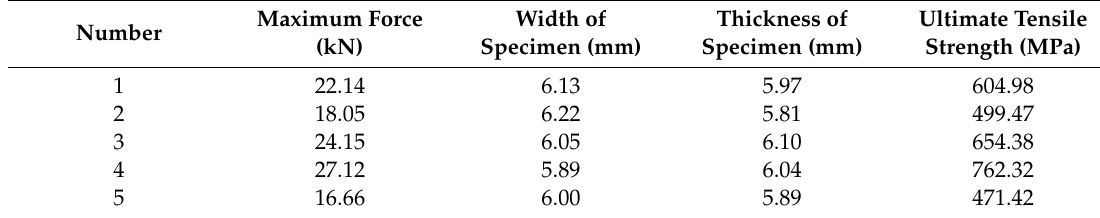
Table 1. Monotonic experimental data and results.